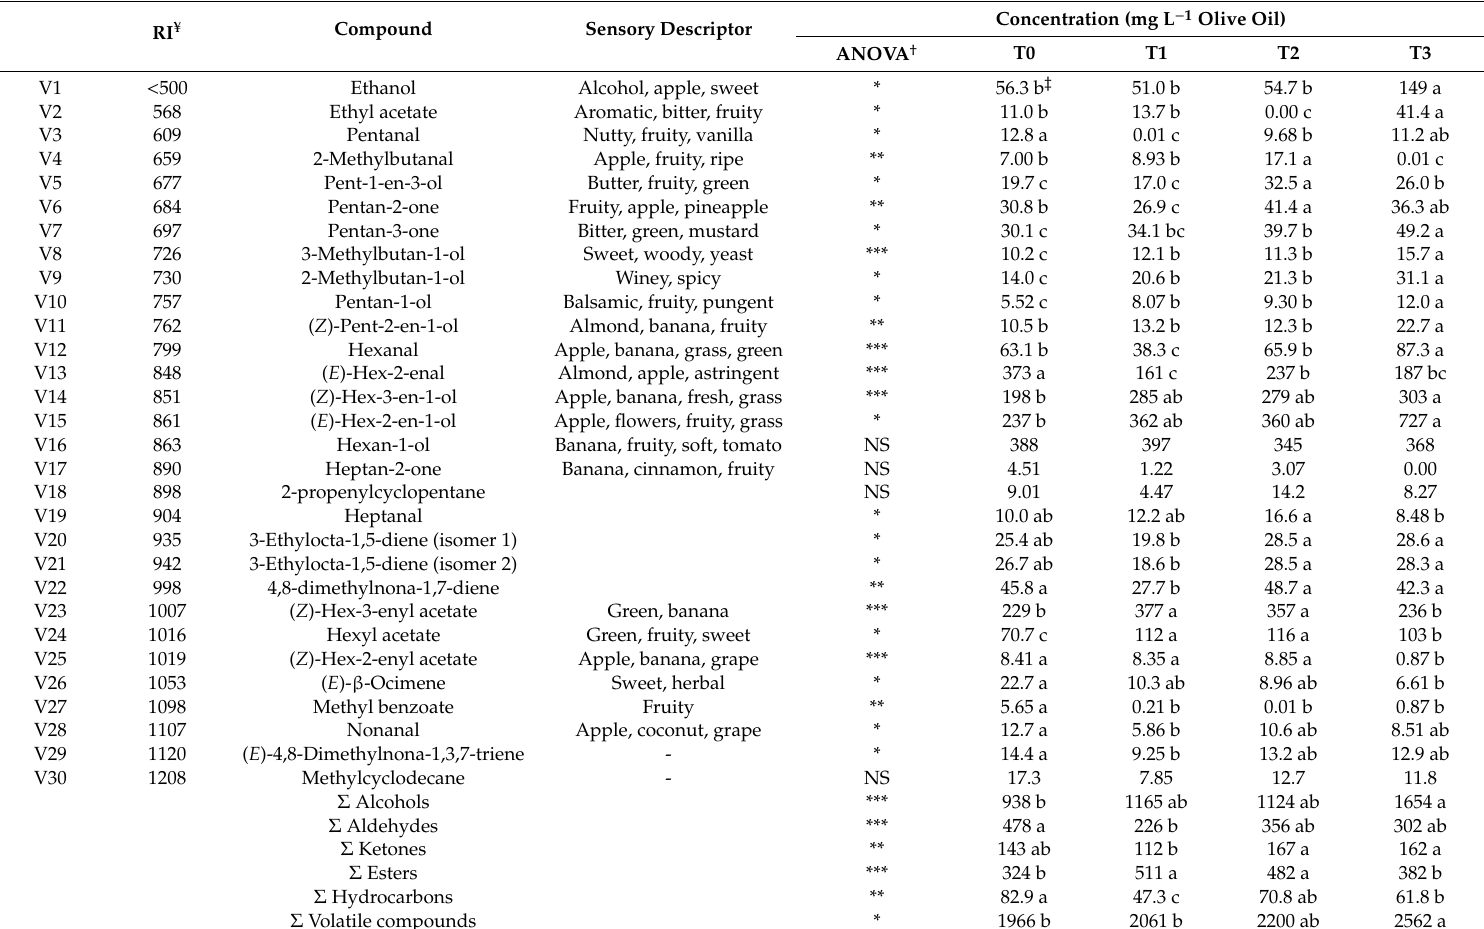
Table 3. Volatile profile (polydimethylsiloxane / divinylbenzene (PDMS / DVB) fiber) of “Arbequina” olive oils as a ff ected by irrigation